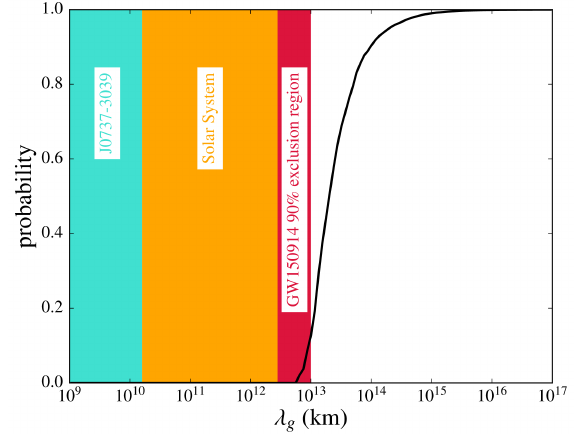
Figure 9. Probability distribution function for the Compton wavelength of the graviton λ g expressed in km is plotted in this figure. The gravitational wave puts better constraints than solar system tests of gravity. (Image credit: